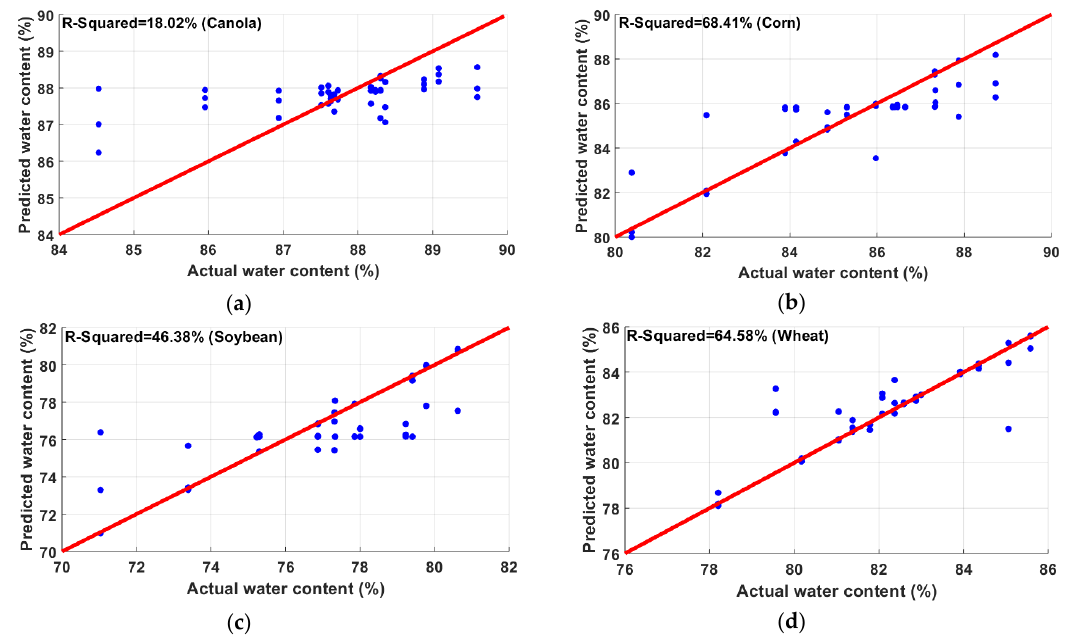
Figure 11. Correlation between the predicted water content and actual water content in ( a ) canola, ( b ) corn, ( c ) soybean, and ( d ) wheat. Corn showed the best correlation of 68.41%, while wheat showed a correlation of 64.58%; on the other hand, canola and soybean did not correlate well.